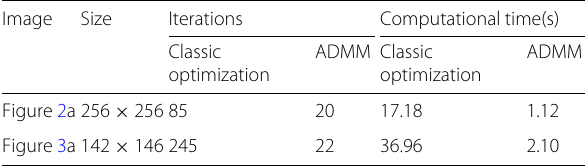
Table 2 Iterations and computational time for Figs. 2a and 3a Image